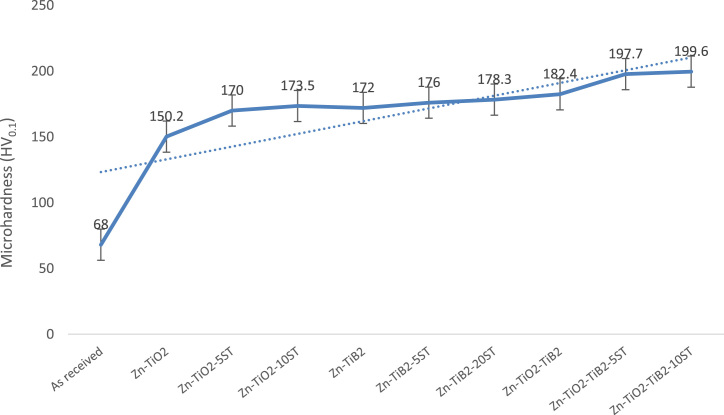
: Experimental trend of variation of TiO2/TiB2/ST on microhardness properties of mild steel.